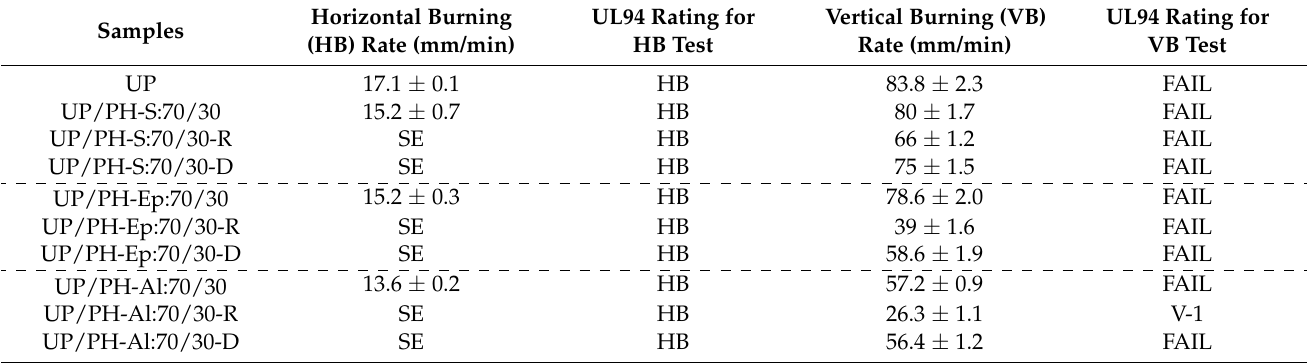
Table 3. UL-94 test results of GFRC samples of UP and of UP/PH co-blended matrices with